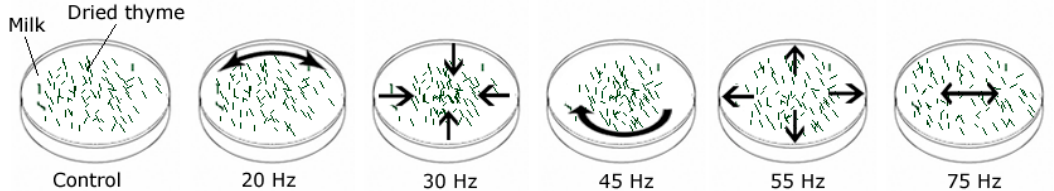
Figure 2. Selected frequencies for sonication and the direction of particle movements obtained. Movements were stationary for control; rotational in both directions for 20 Hz; grouping in the center for 30 Hz; rotational clockwise for 45 Hz; segregation movement for 55 Hz and horizontal bidirectional movement for 75 Hz.